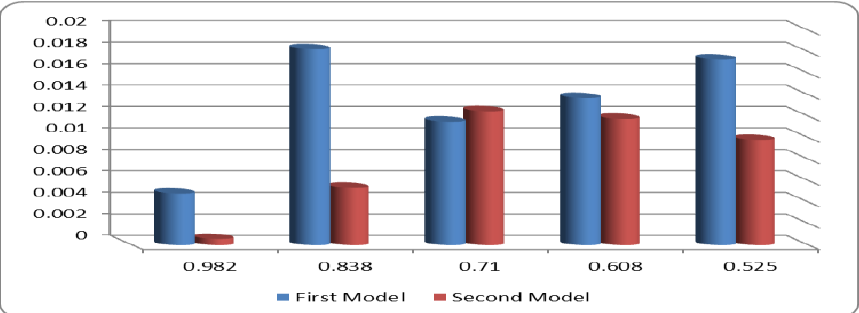
ˆ R for the first and second model at (2, 2). Figure 5. MSEs of ˆ R ˆ R and ˆ R 2 for the first and second model at (2, 2). 1 and 1 2